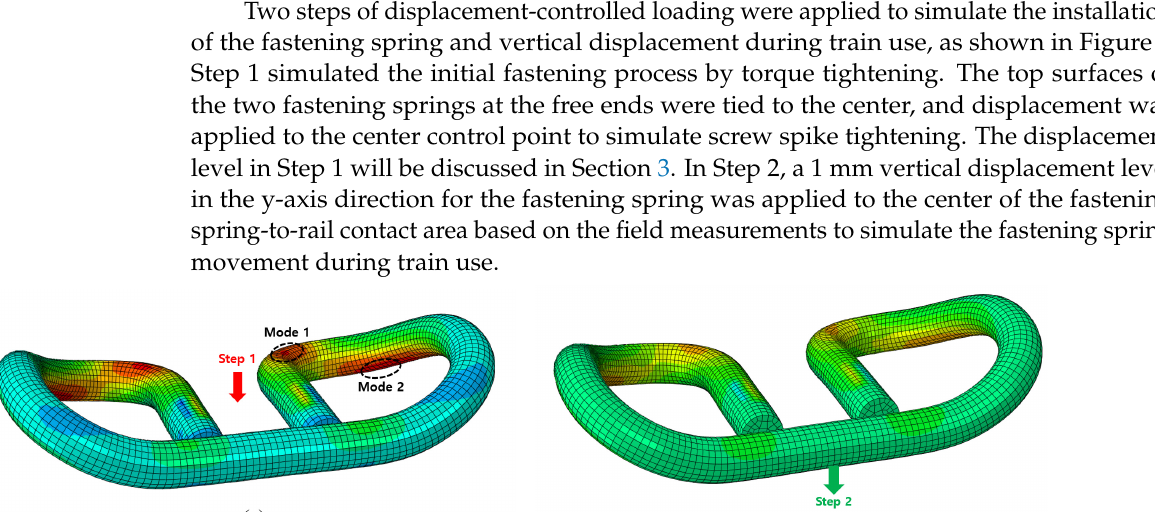
Figure 2. Finite element analysis modeling: ( a ) model configuration; ( b ) material model.